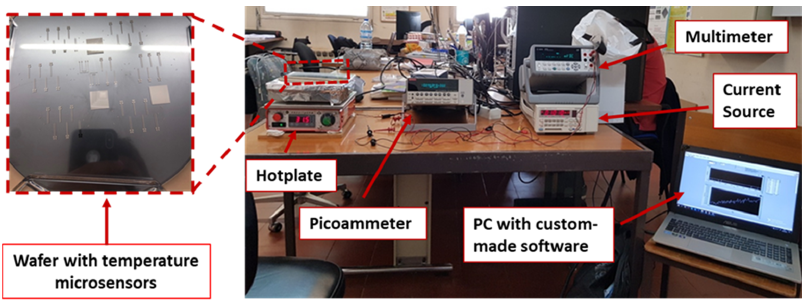
Figure 7. Experimental setup used for the temperature microsensors characterization.